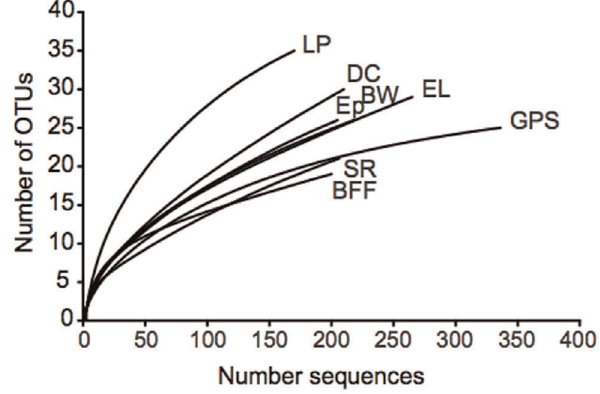
Figure 1. Rarefaction curves of the sequenced clones for each orchard. The sequences were binned into OTUs at the 97% similarity threshold. doi:10.1371/journal.pone.0037131.g001 PLoS ONE |